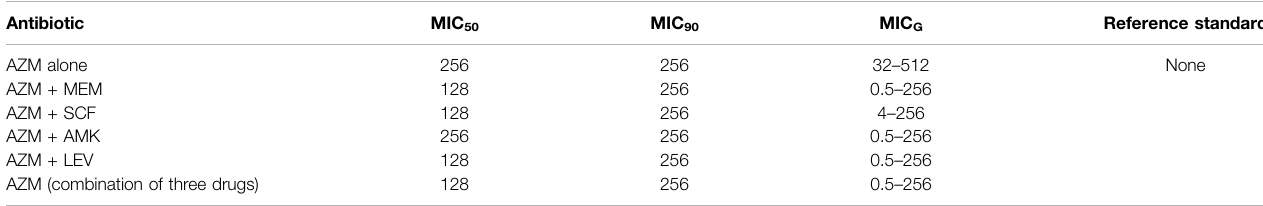
TABLE 6 | MIC values of the AZM single drug or after combination against the 25 isolates of MDR P. aeruginosa (ug/mL).